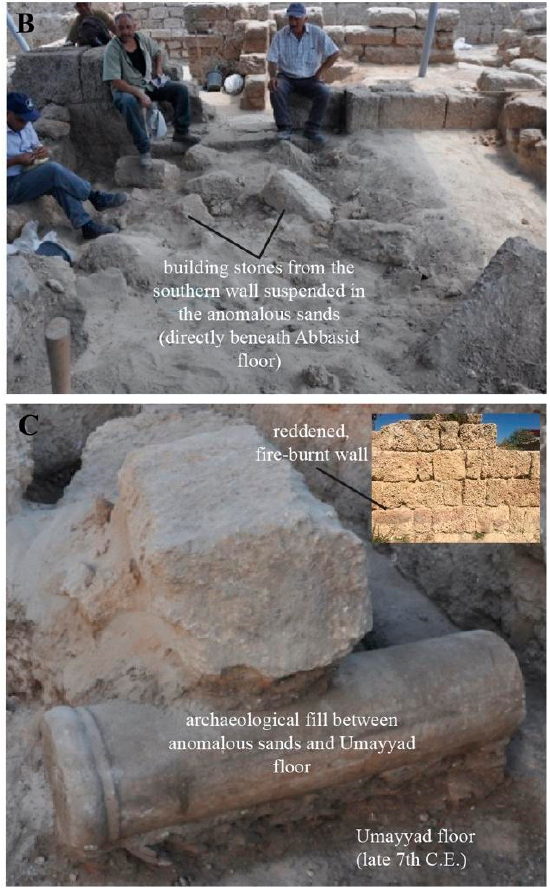
Figure 2. Archaeological layers uncovered during the 2016 excavation. Chronology in the figure is based on archaeological finds associated with the layers [46]. ( A ) Abbasid floor. ( B ) Anomalous layer (the top of which touched the Abbasid floor above). ( C ) Umayyad archaeological fill directly underlying the anomalous deposit. Inset shows fire-burnt stones in the eastern wall of the corridor, at the same level as the top of the Umayyad archaeological